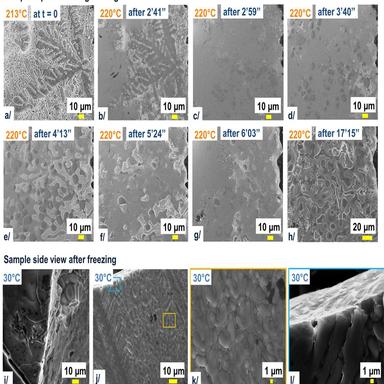
a/−h/View from the sample top held at 220 °C because of the rapidity of the observed phenomenon: Example of the oscillatory motion effect due to the reaction and infiltration of the LiBr-rich liquid with the LiOH evolving structure once it has been fully covered during the heating step, i/−l/ View from the sample side during another similar experiment fastly cooled up to 30 °C.